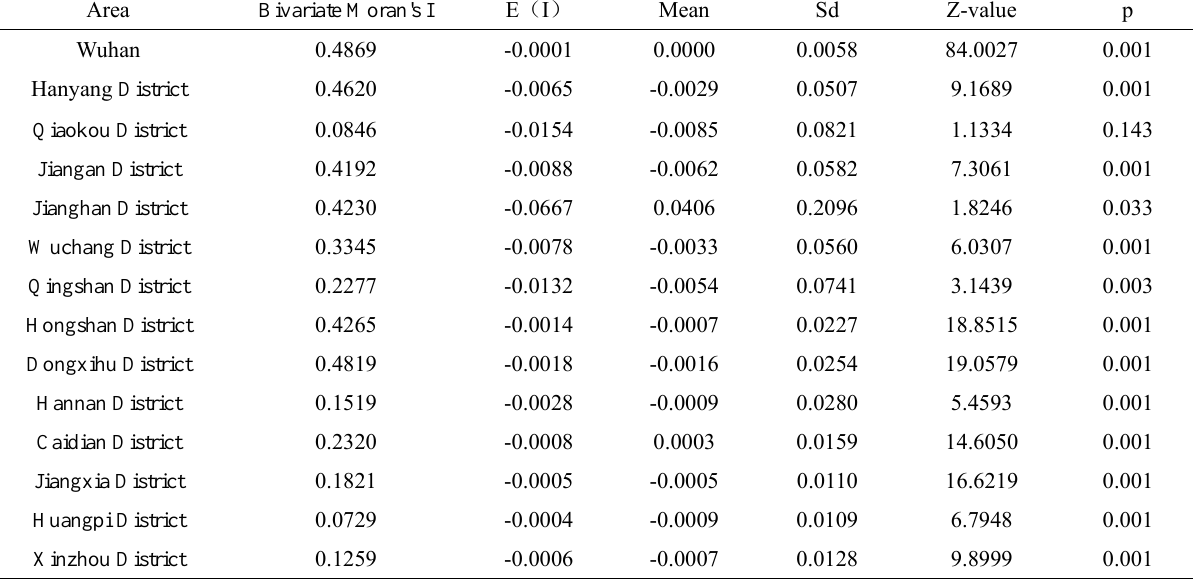
Table . 1 Calculation results of Bivariate Moran’s I for public transport service